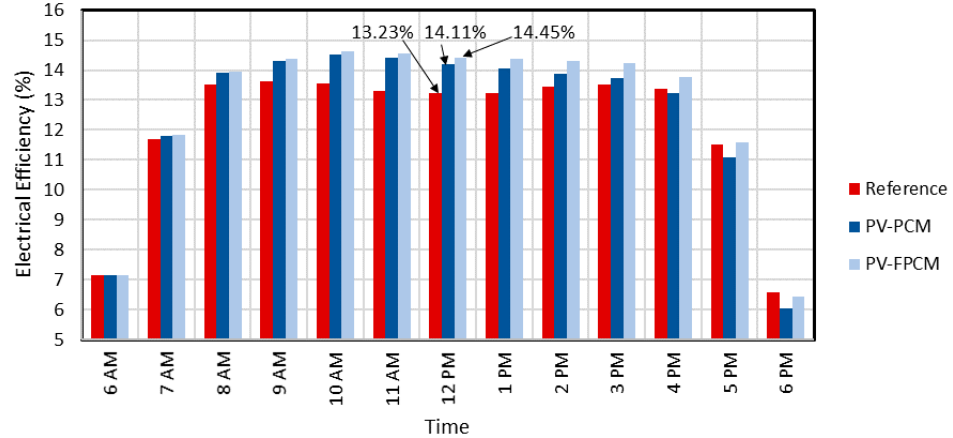
Figure 7. Electrical efficiency of reference system, PCM cooled system and FPCM cooled system.